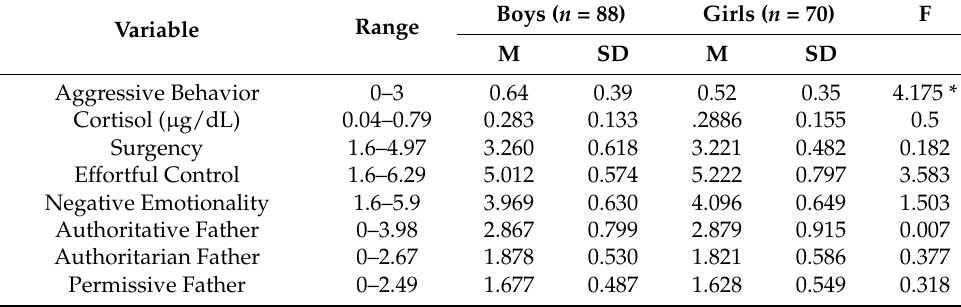
Table 1. Descriptive statistics and analyses of variance.